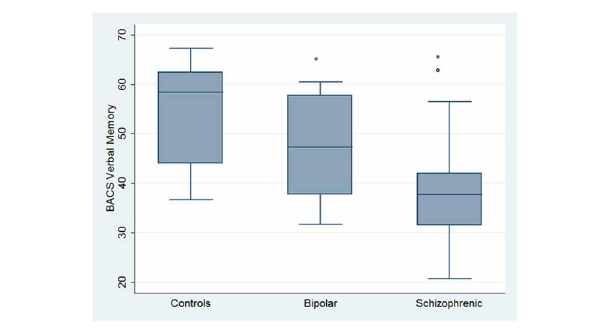
FIGURE 1 | Differences between groups in neuropsychological tasks: BACS verbal memory. ∗ Significantly different from HC ( p < 0 . 05). ◦ Significantly different from BD ( p < 0 . 05).